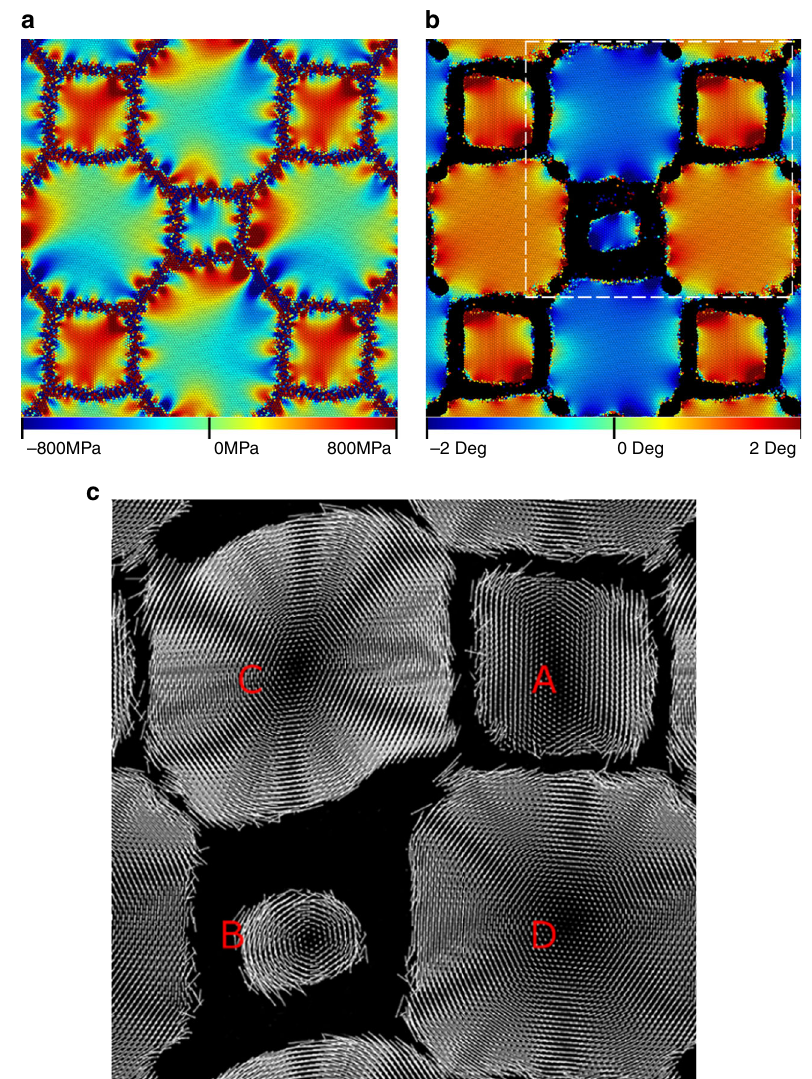
Fig. 4 Stress generation and lattice rotation in the idealized microstructure. a σ xy , b grain rotation, and c displacement vectors from 5.5 ns into the evolution of the idealized microstructure. There is a large positive stress accumulation in Grain A and lattice rotation in Grain B. Displacement vectors are scaled by a factor of 20 for visual clarity and grain labeling in c is consistent with Fig. 3a. The white box in b denotes the viewing boundaries in c . Displacement vectors for atoms with very large displacements (such as those through which a GB has migrated) were removed for clarity. The rotation in b was calculated as the curl of the displacement fi eld depicted in c . For full animations corresponding to a , b see Supplementary Videos 3 and 4,